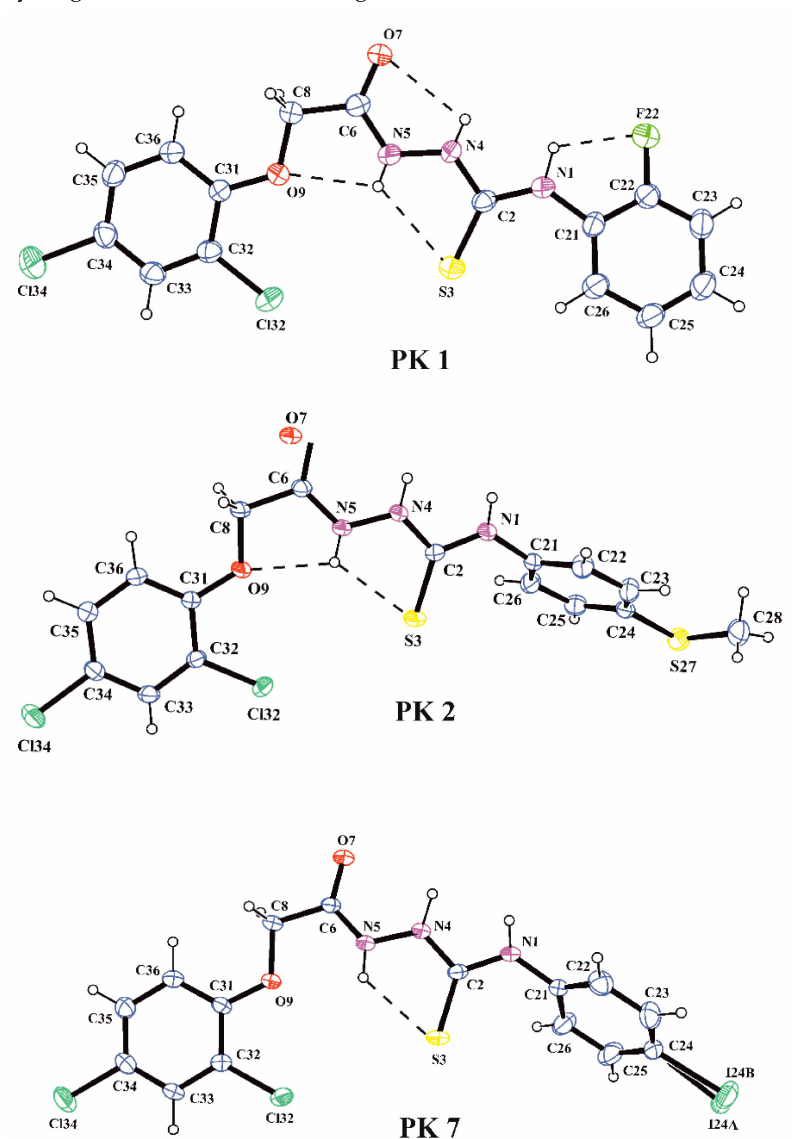
Figure 1. A view of the X-ray molecular structures of PK1, PK2 and PK7 with the atomic labeling scheme (probability 30%). Dashed lines indicate intramolecular hydrogen